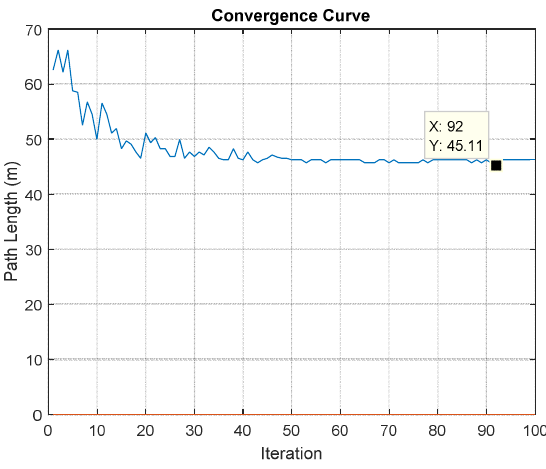
Fig. 23. The Convergence Curve for Experiment 3 From the previous two figure, the mobile robot start avoids static obstacles with the shortest path computation time equal to (52.017160).